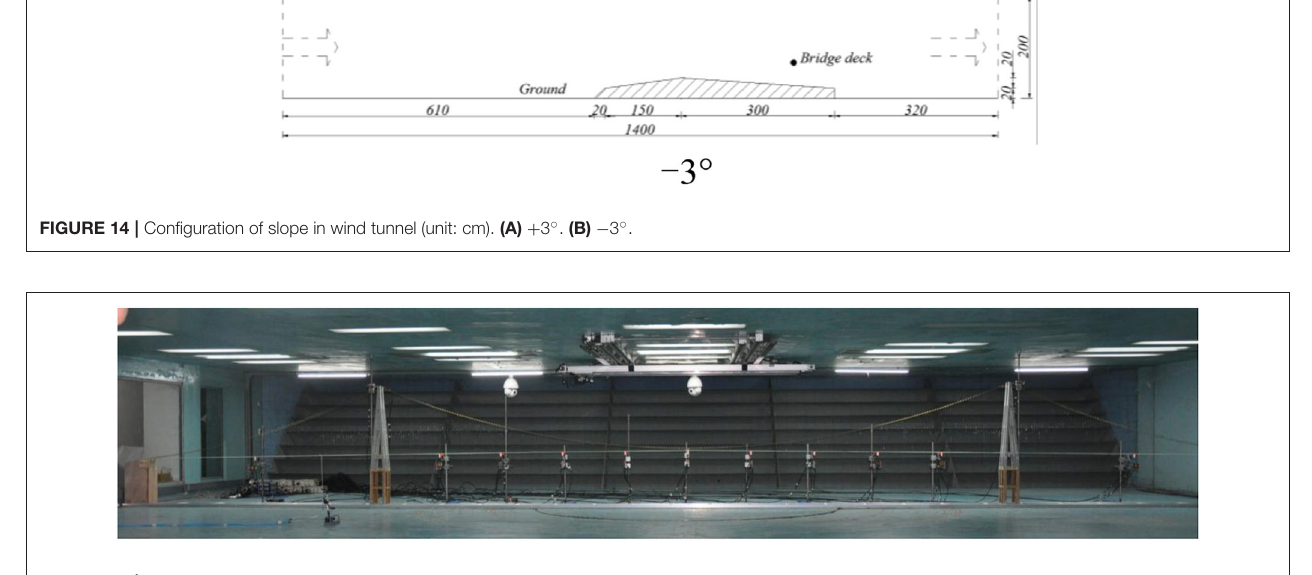
FIGURE 15 | Setting of laser